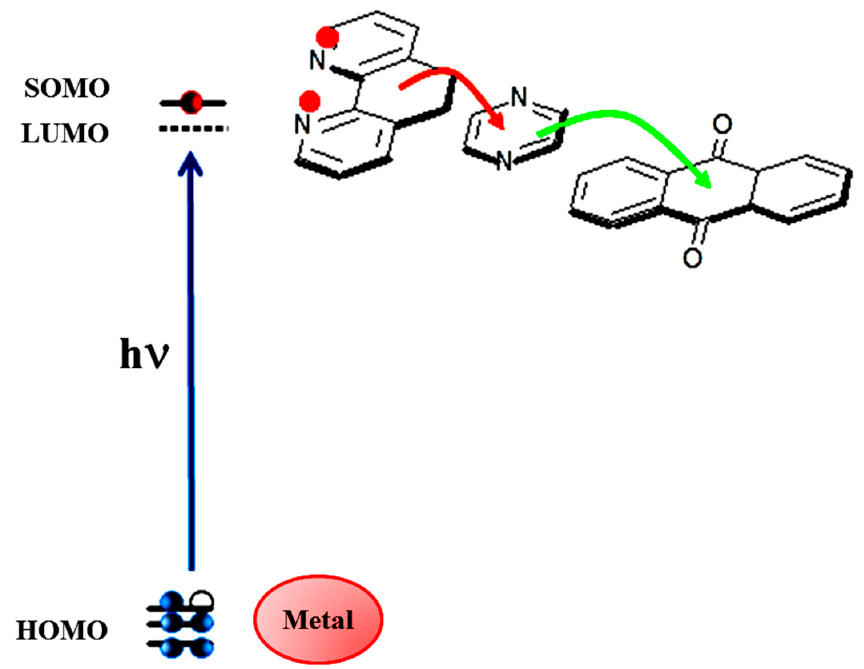
Figure 2. The excited state redistribution of the electronic density after the excitation from the ground state to the metal ligand charge transfer